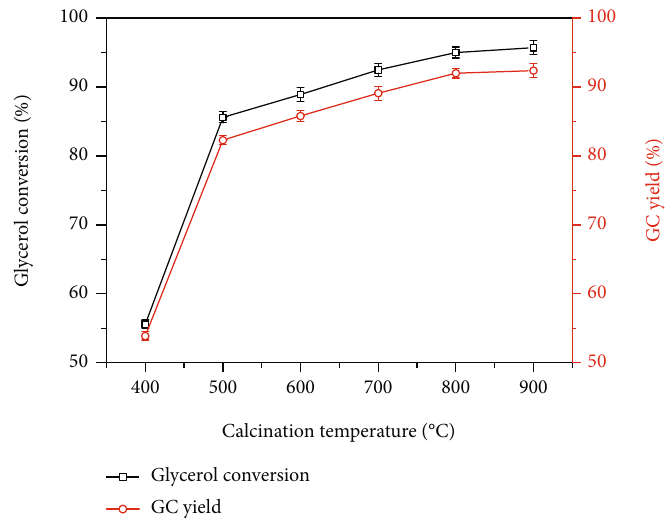
Figure 2: E ff ect of calcination temperature on glycerol conversion and GC